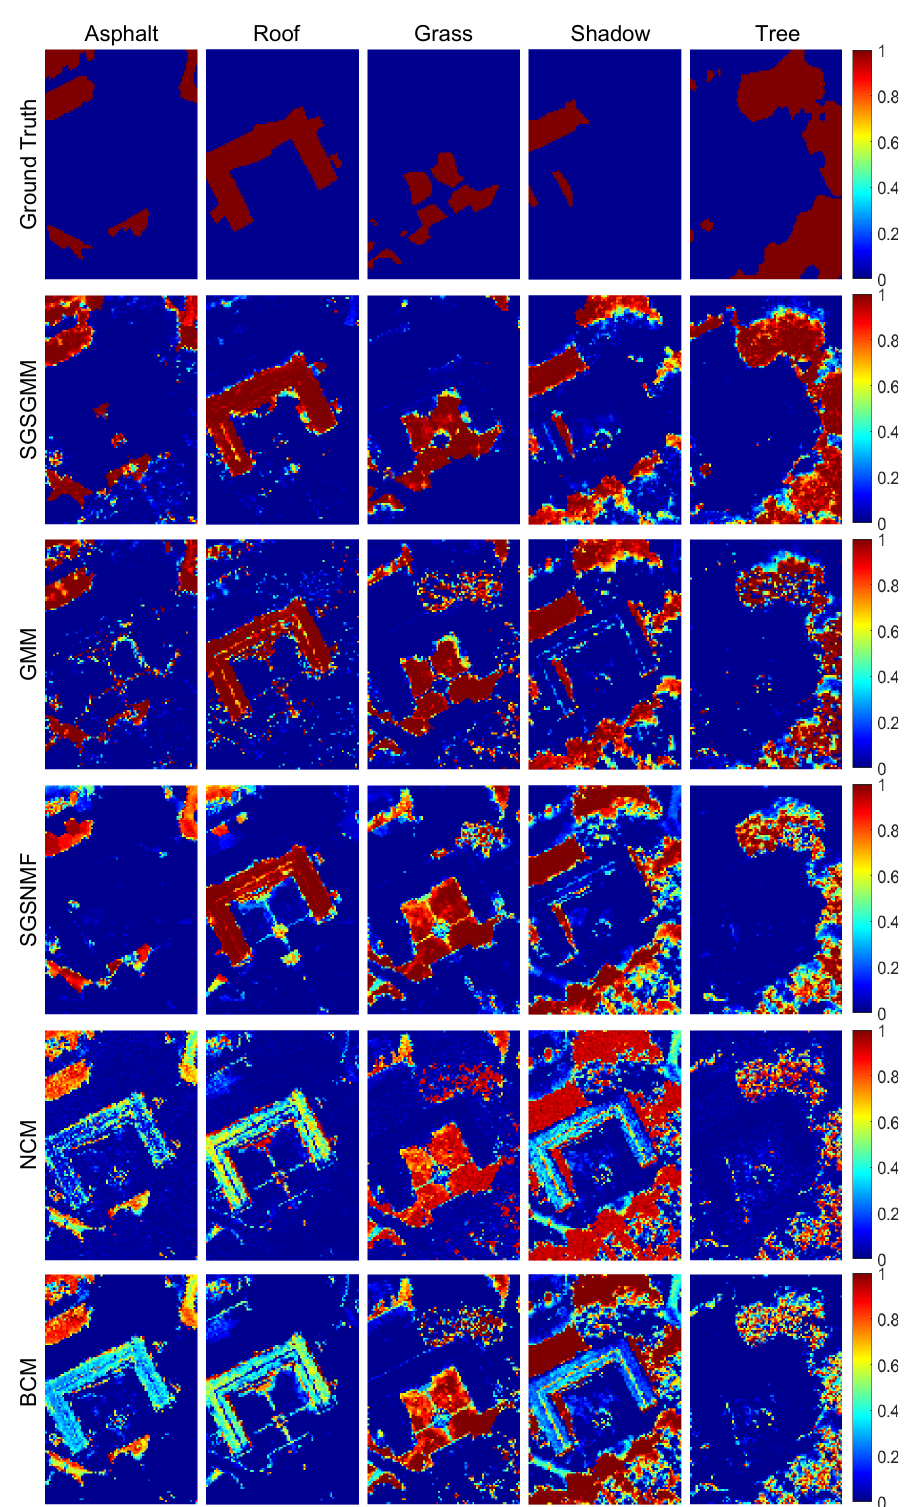
Figure 7. Abundance maps comparison for the ground truth, SGSGMM, GMM, SGSNMF, NCM, and